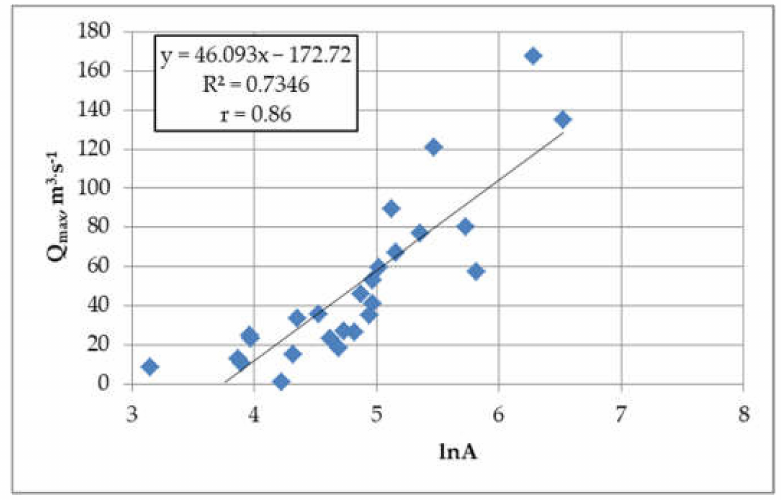
Figure 11. Relationship between catchment area and annual median peak discharges; the line is a regression described by y = 46.093 x − 172.72.